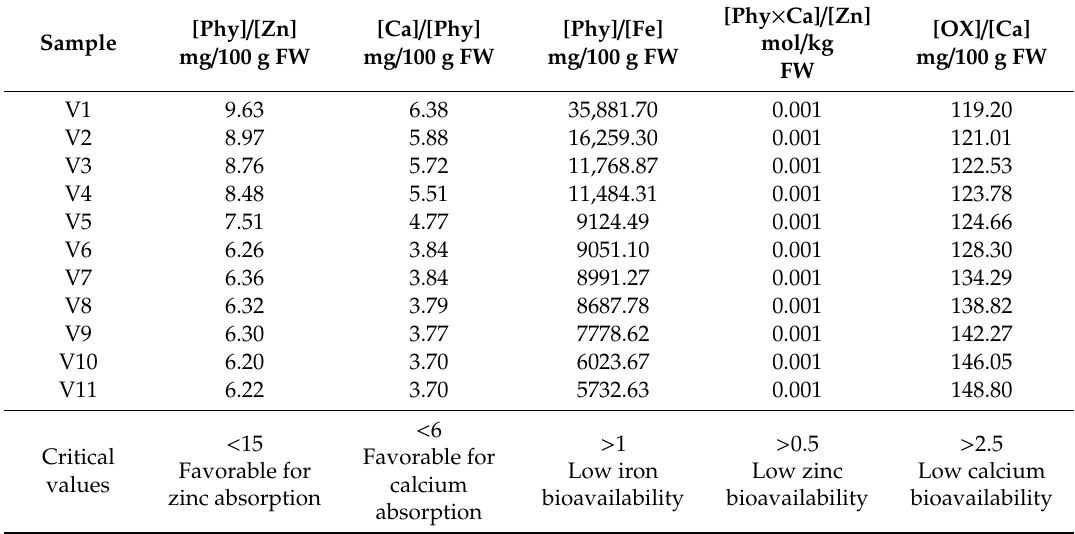
Table 4. Bioavailability of zinc, calcium, and iron in the tomato fruits of cv. Brillante